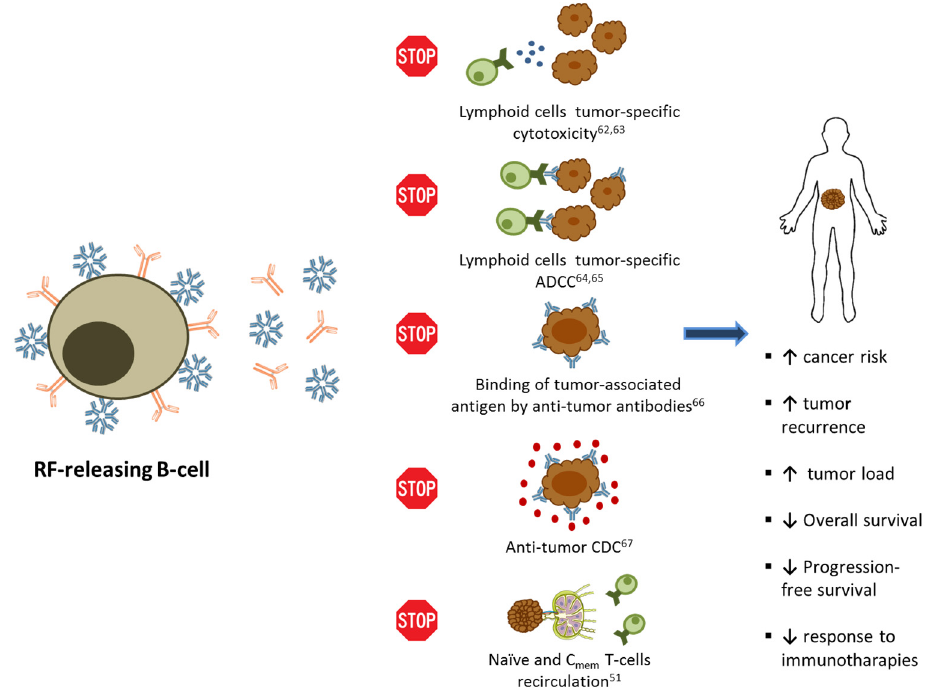
Figure 2. Schematic representation of the different in vitro immune-suppressive activities of RFs in the context of anti-tumor responses with their effects on cancer patients.